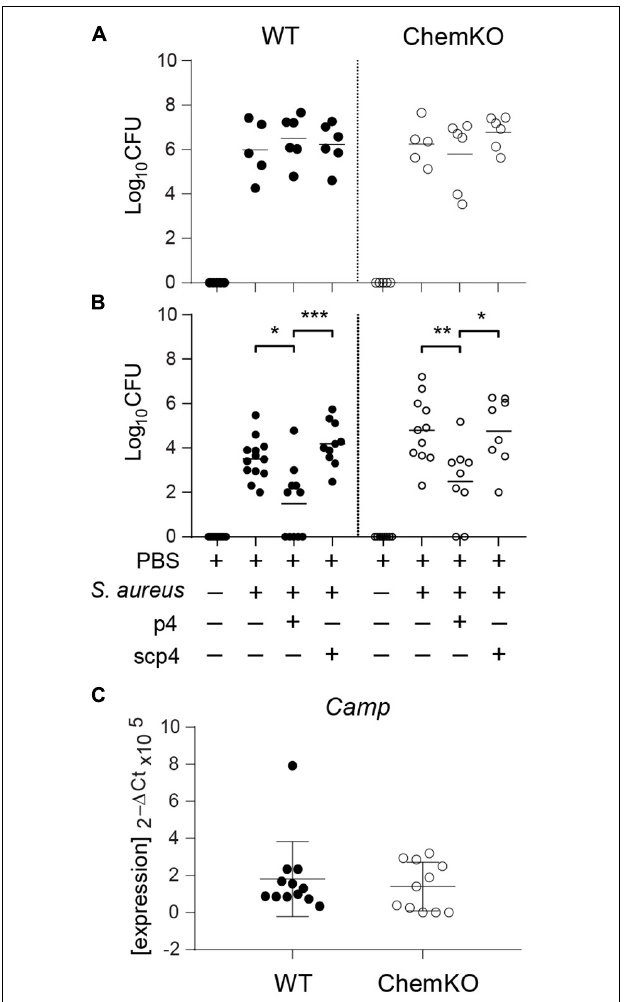
FIGURE 2 | p4 limits experimental S. aureus infection in vivo . WT and ChemKO mice were treated with vehicle (PBS) or were topically infected with 1 × 10 7 CFU of S. aureus 8325-4 in the presence of 100 µ M p4, control peptide scp4, or PBS. (A) Data points indicate the number of bacteria recovered from the skin surface 3 h after application of bacteria. (B) Data points indicate the number of live bacteria recovered from the skin surface 24 h after application of bacteria. (C) Data points indicate Camp expression levels in the skin treated with PBS for 24 h. Each data point represents one cavity, and a horizontal line indicates the mean value in each group; n = 5–10 independent experiments (1–2 mice per group). *** p < 0.001; ** p < 0.01; * p < 0.05 by the Kruskal–Wallis test with post hoc Dunn’s multiple comparisons test and one-way ANOVA with Tukey’s post hoc test.